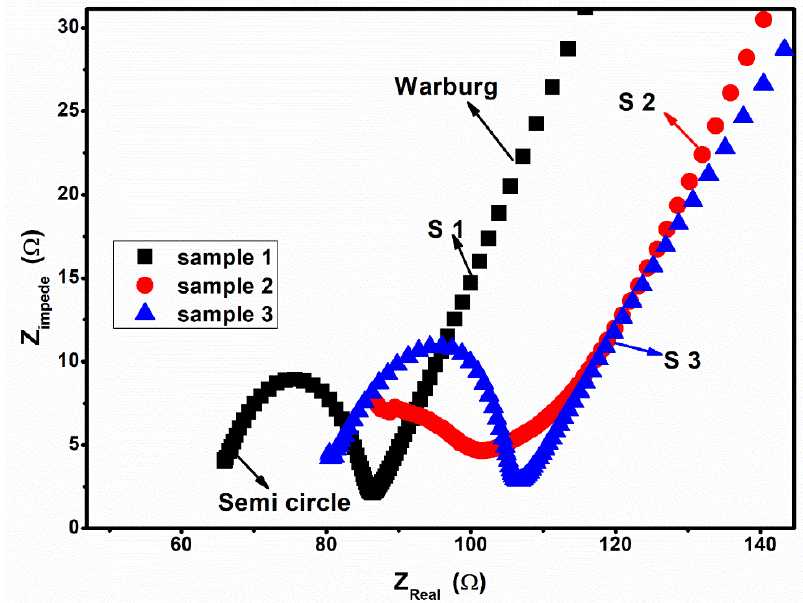
Figure 9. Nyquist plot of GCE/ CuO-TiO 2 30/70 (S1) GCE/ CuO-TiO 2 50/50 (S2): GCE/ CuO-TiO 2 70/30 (S3) in 0.5 M H 2 SO 4 as an electrolyte.